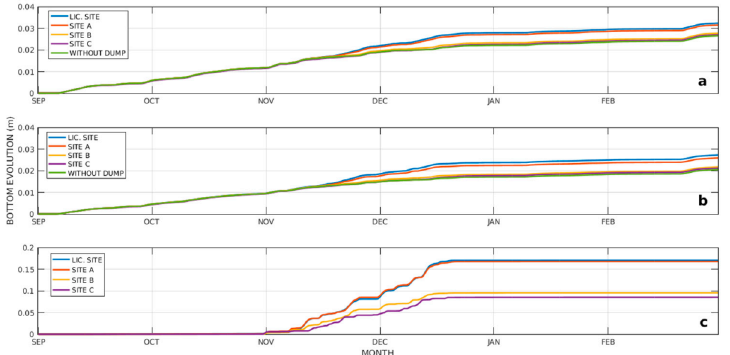
Figure 12. Calculated bottom evolution (m) time series at ( a ) Cassino and ( b ) Quer ê ncia when considering the simulations without any discharge (only natural contribution from Patos Lagoon), with discharges occurring in the Licensed Site and alternative Sites A, B, C (in colors). ( c ) Calculated time series of bottom evolution extracted at points of maximum bottom evolution inside each disposal site. Figures have different vertical scales to improve visualization.